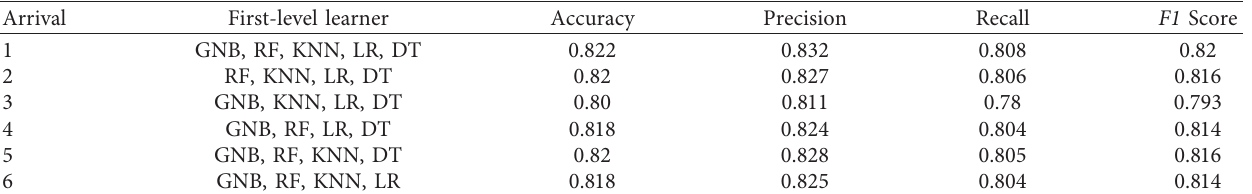
Table 5: The arrival departure prediction results of different first-level learners.